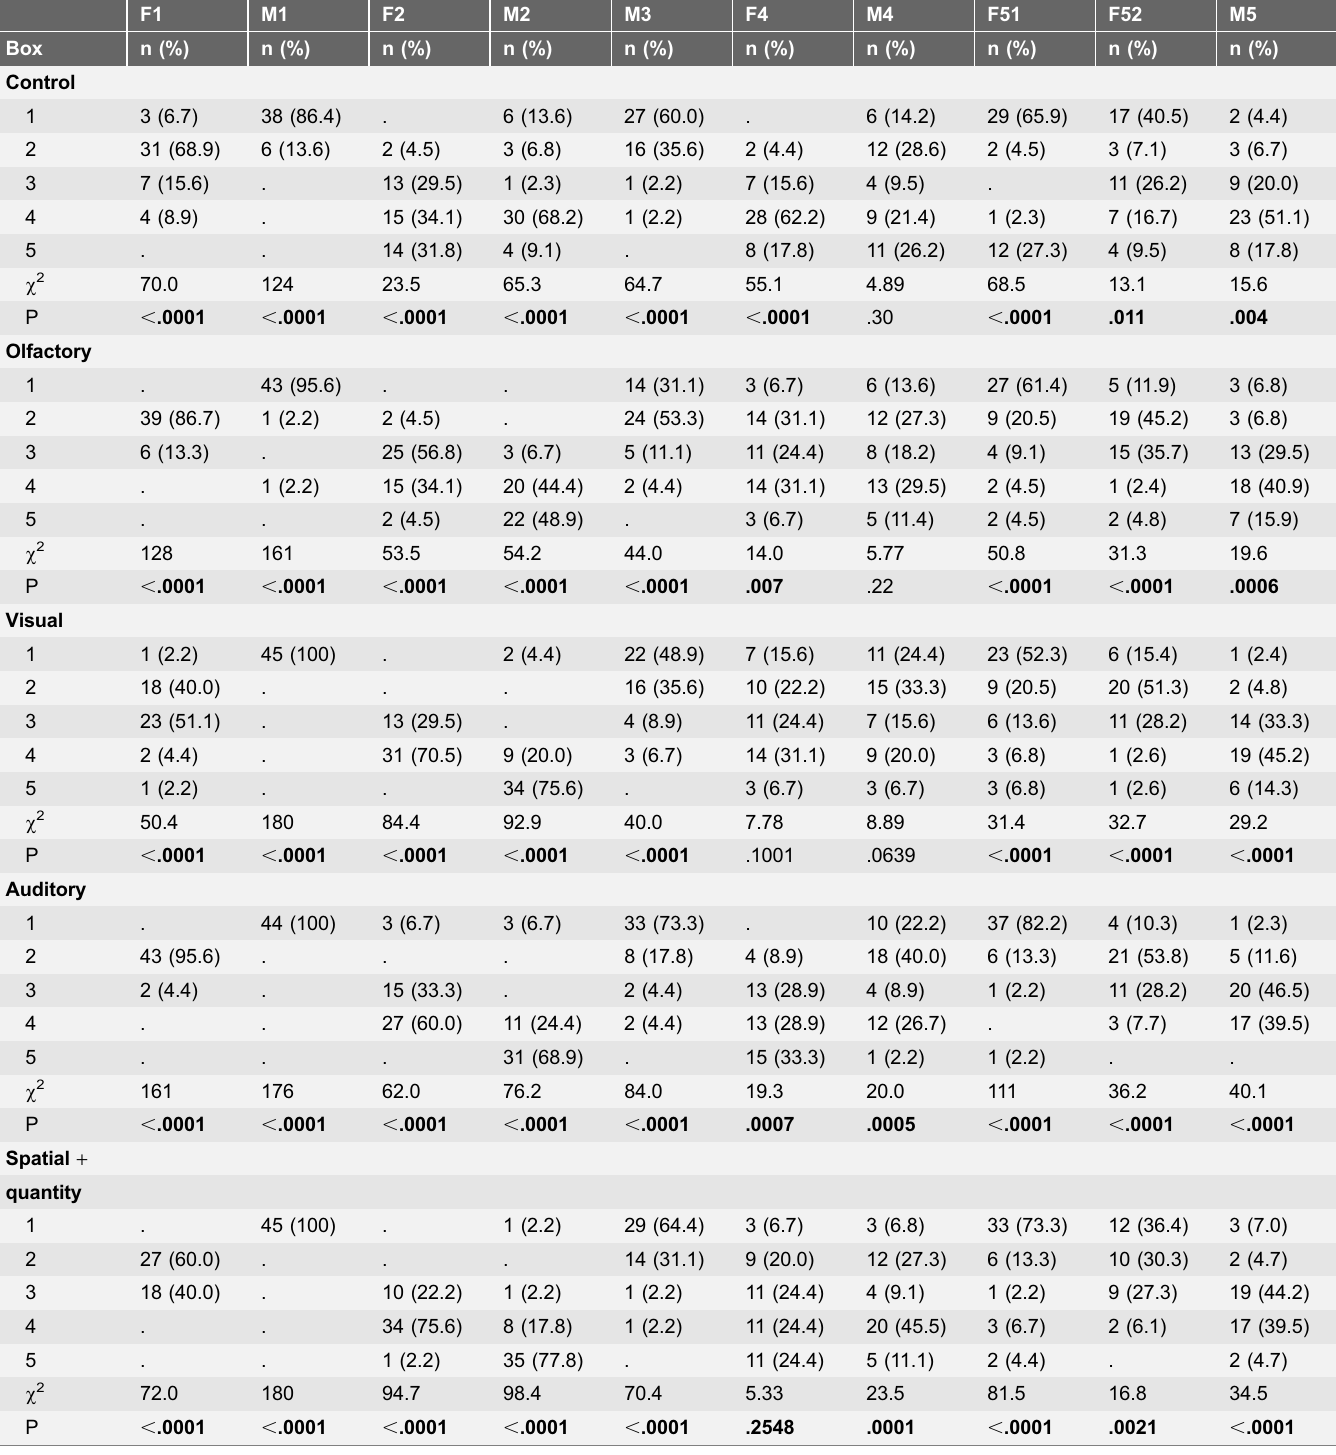
Table 3. Frequency of box choice for the first inspection in each session (n and respective %) and the result of the chi-square test to assess the preference for certain boxes ( x 2 and P; d.f. 5 4 for all) is also shown.